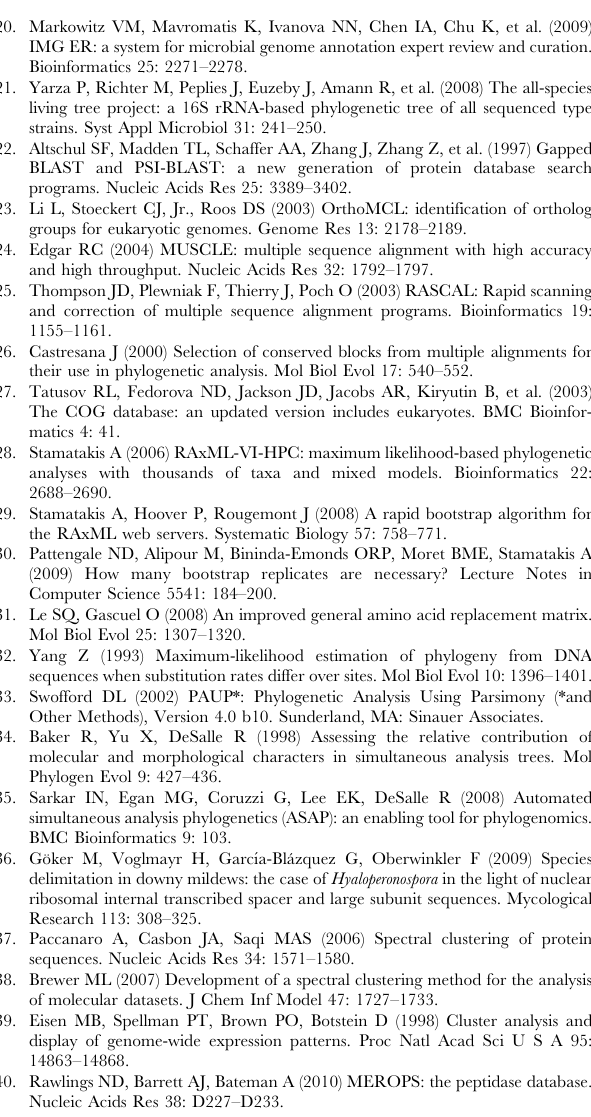
Table S3 Signature clusters. Spectral clusters found in all haloarchaeal genomes and not found in any other sequenced archaeal genome. The predicted function and locus tags are listed. Table S4 Habitat-specific clusters. Spectral clusters found exclusively in one habitat type and not in the other habitat type. The predicted function and locus tags are listed. Table S5 Organisms used in this study and the RefSeq accession numbers for their genome